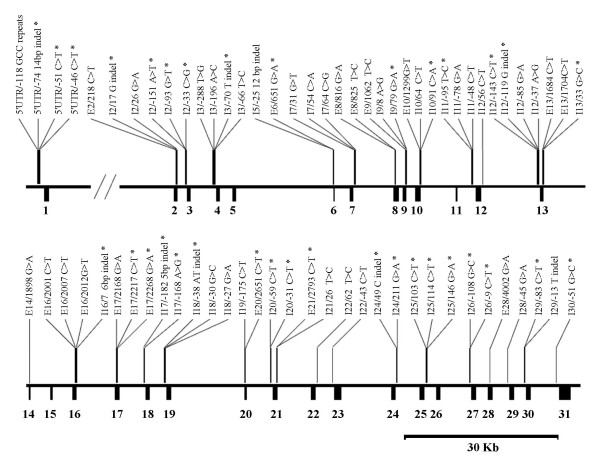
Distribution of polymorphisms identified in this study across MRP1. The respective positions of all the polymorphisms across MRP1 are displayed. Polymorphisms at this locus include 60 SNPs, ten indels and one short tandem repeat (STR). Polymorphisms that have not been previously reported are highlighted with asterisks.